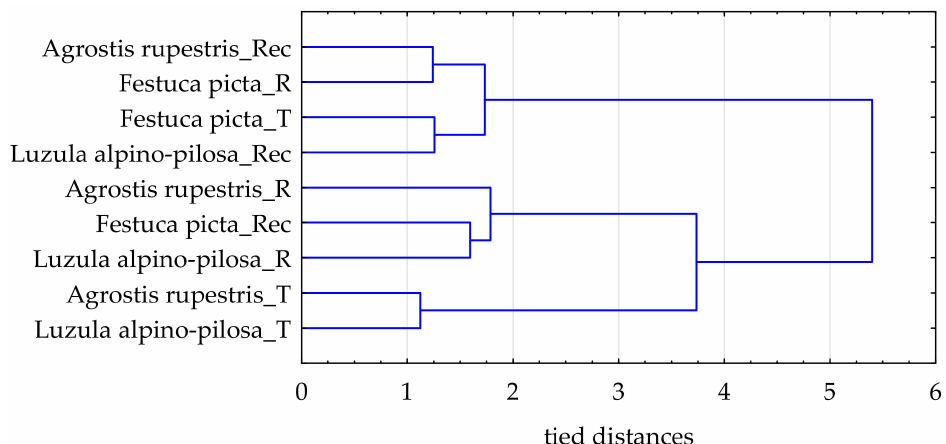
Figure 3. Agglomeration of spectral curves in the electromagnetic spectrum (350–2500 nm; Ward’s method) acquired in 2012–2014 for dominant species, n = 148,125. Explanations: AR_T—Agrostis